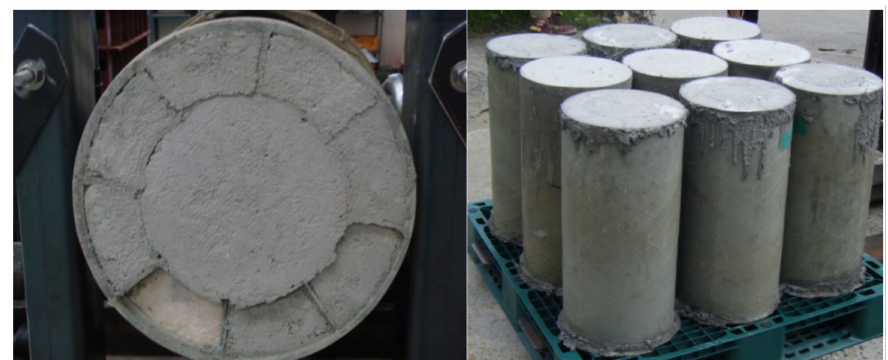
Figure 12. Specimen for compressive strength testing of the hybrid-CFFT.